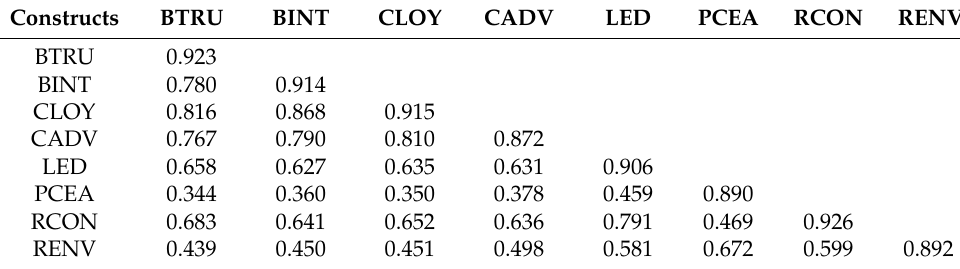
Table 4. Fornell–Larcker